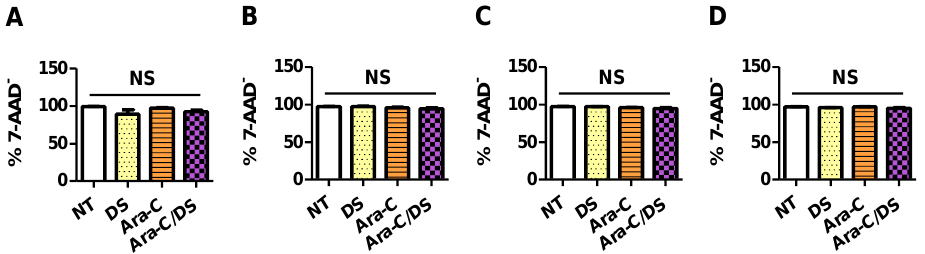
Figure 6. Cytotoxic potential of Ara-C/DS at low dose. Cell viability of ( A ) HCT 116, ( B ) HT-29, ( C ) A2780 and ( D ) A2780R treated with Ara-C/DS, or its components (50 nM Ara-C, 1 µg/mL DS) was assessed by 7-AAD stain after 48 h (data presented as the average of six independent experiments, n = 6 ± SEM). Statistical differences were calculated by one-way ANOVA with Tukey’s post hoc tests. NS: not significantly different.